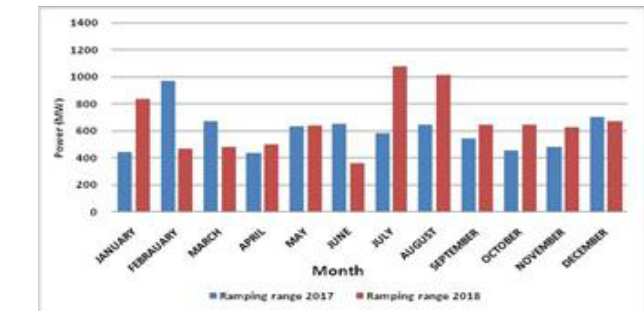
Figure 32. Comparison between RCIs for the standard deviation of downward power ramps in 15 min interval for each month for years 2017 and 2018.